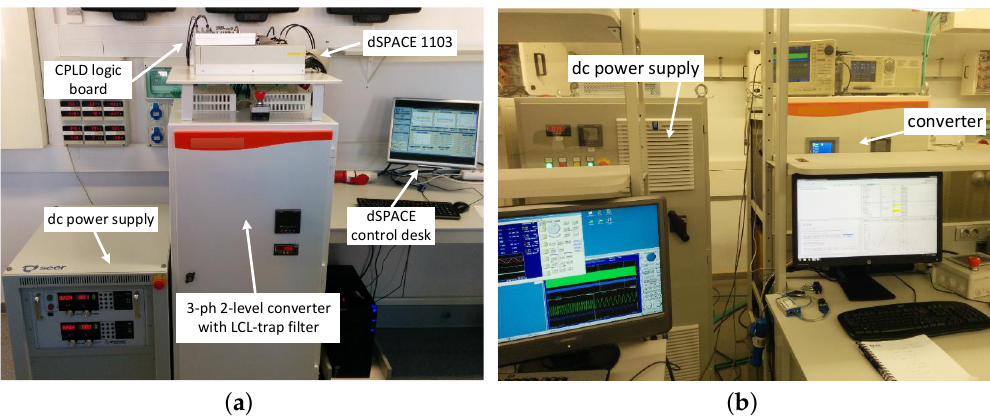
Figure 11. Experimental setups: ( a ) 10-kW test bed and ( b ) 100 kW-test bed.